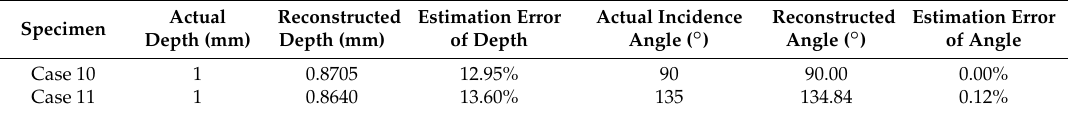
Table 6. The depth and angle evaluations of Case 10 and Case 11.